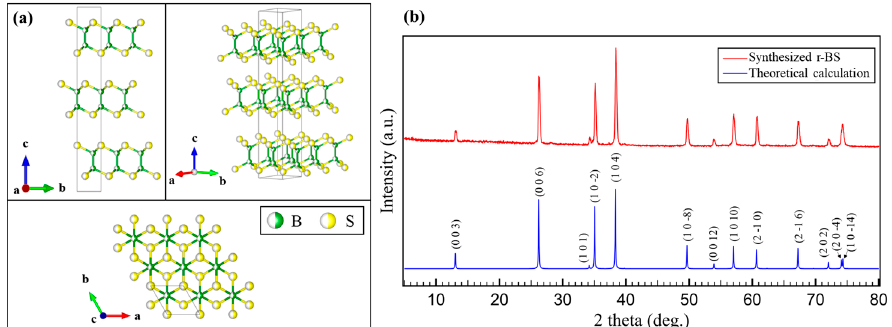
Figure 1. ( a ) The structure of r-BS [23] and ( b ) X-ray diffraction patterns (CuK α : λ = 1.5418 Å) of r-BS obtained via a high pressure synthesis method, and those of the theoretically calculated structure [18].